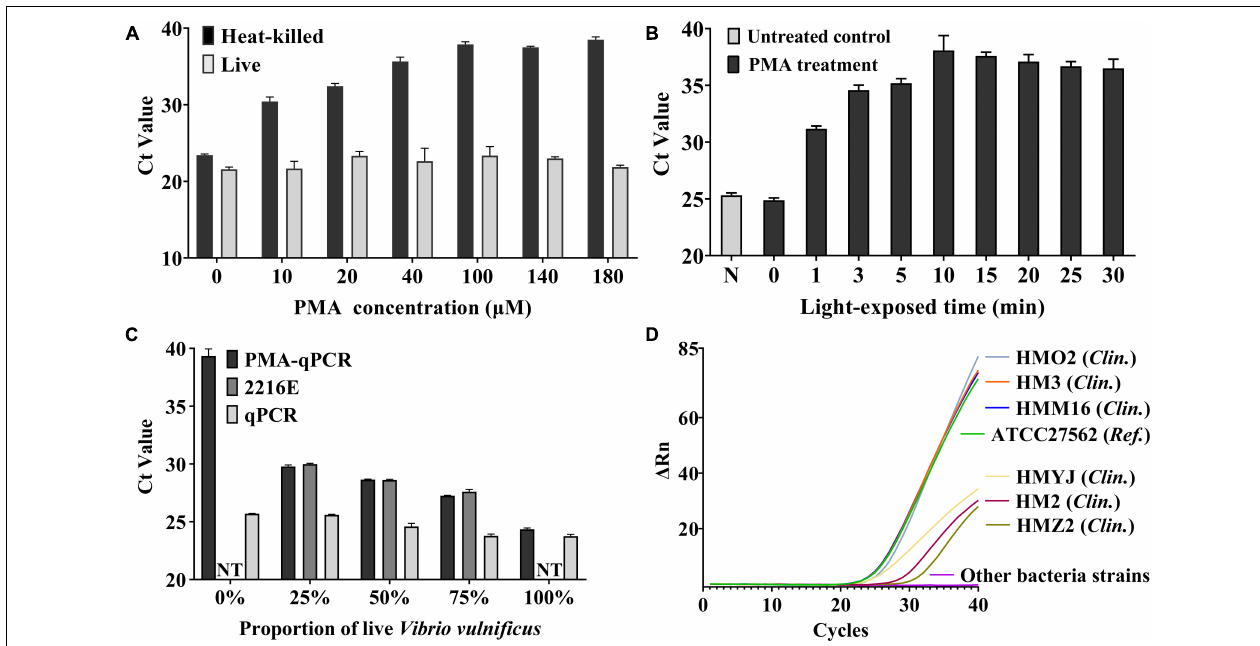
FIGURE 3 | (A) Optimization of final PMA concentration. The different concentrations (10–180 µ M) of PMA were treated on live V. vulnificus cell suspensions and heat-killed cell suspensions. Error bars represent the standard deviation based on three replicates. (B) Optimization of light-exposed time. The different light-exposed times were treated on heat-killed cell suspensions. N: PMA untreated control. Error bars represent the standard deviation based on three replicates. (C) Verification of the ability to detect live V. vulnificus cells by PMA-qPCR. The different concentrations (0–100%) of live cells were mixed with heat-killed cells and treated with PMA (PMA-qPCR group) or not (qPCR group). While the 2216E group was the blank control which was the corresponding concentration of live cells mixed with 2216E liquid medium. NT, no test. When the proportion of live V. vulnificus was 0% and 100%, the samples were pure dead bacterial solution or live bacterial solution, and it is not necessary to mix with 2216E medium. Error bars represent the standard deviation based on three replicates. (D) Specificity test of PMA-qPCR. Only the above seven V. vulnificus strains were observed positive signals. Clin. , clinical strain of V. vulnificus isolated from clinical samples; Ref. , reference strain of V. vulnificus .